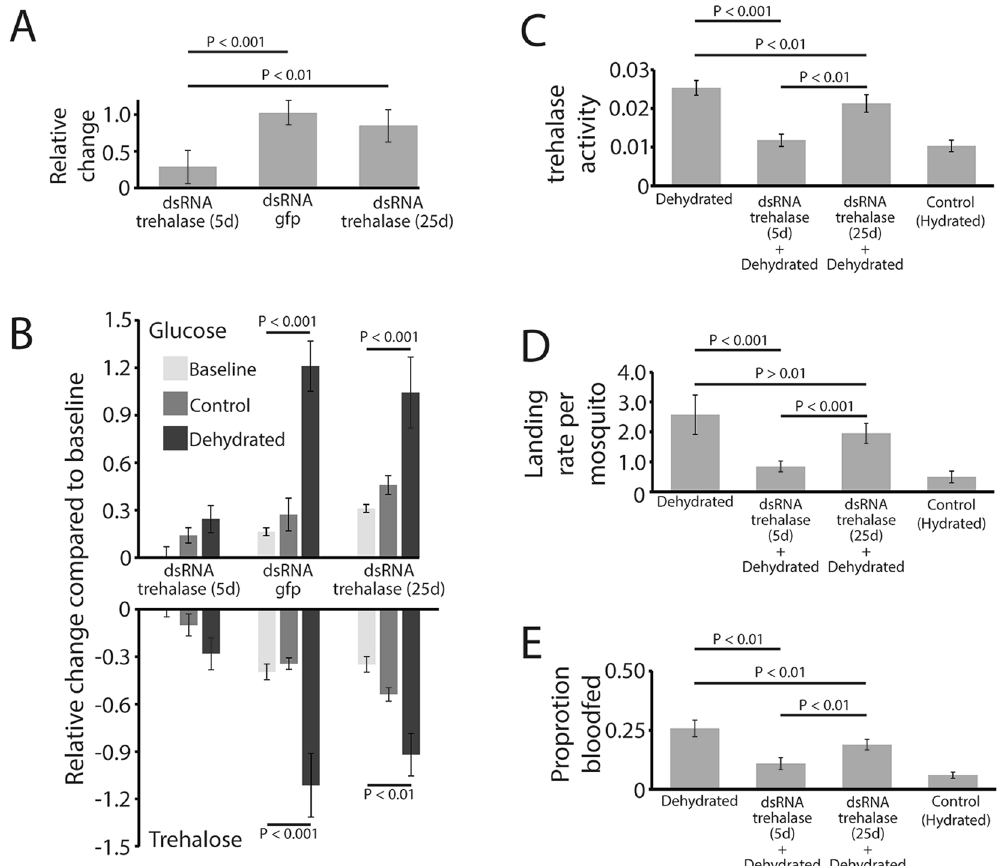
Figure 4. Glucose and trehalose shifts directly impacted mosquito blood feeding-dehydration dynamics for C . pipiens females. ( A – C ) Knockdown of trehalase prevented the trehalose to glucose conversion during dehydration by suppressing trehalase activity. Trehalase activity is in mol glucose/ µ g protein/minute. Mean ± SE for 12 mosquitoes at each time point. ( D , E ). Landing on the host (mean ± SE for 8 replicates at each time point) and blood feeding (mean ± SE for 8 replicates at each time point) changed following trehalase suppression and dehydration. Statistical analyses were conducted by a one- or two-way ANOVA followed by Tukey’s HSD post- hoc analysis where appropriate. 5d and 25d are periods following injection of dsRNA. Control, mosquitoes held at 100% RH for 18 h. Dehydrated, mosquitoes held at 75% RH for 18 h. Baseline denotes levels before 18 h of